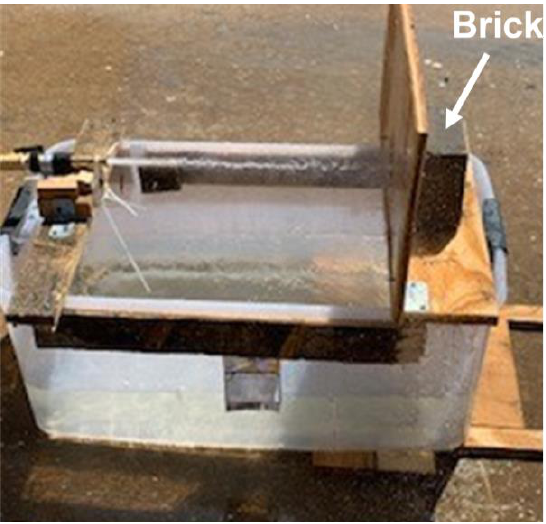
Figure 4. Modified Water Erosion setup. A specific flow of water impacts the brick for three hours simulating 15 years of rainfall erosion.